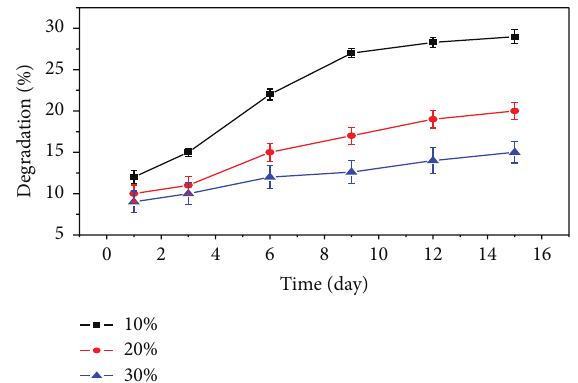
Figure 10: In vitro degradation of the GCB with different bioglass contents in PBS.